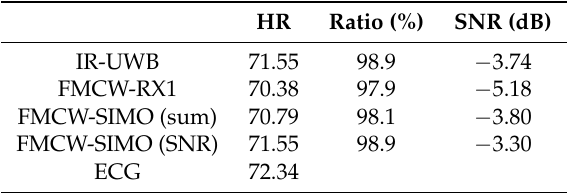
Table 7. HR Results of measurement with